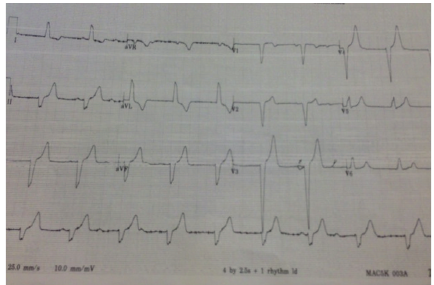
Figure 3: Followup EKG revealing complete AV block along with left bundle branch block and a ventricular rate of ∼ 55bpm.